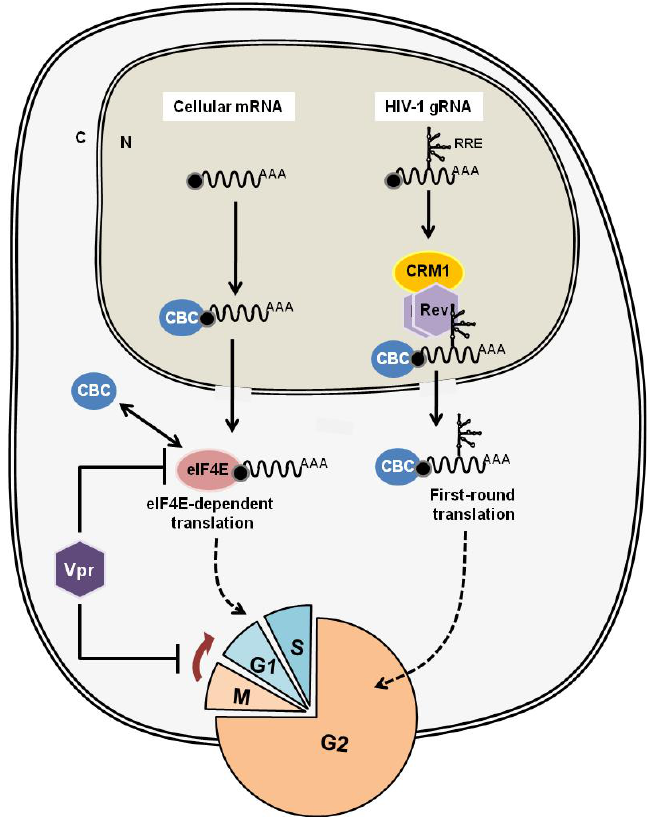
Figure 3. The G2-­‐‑arrest by Vpr is beneficial for the selective translation of viral proteins. In the regular mRNA translation, the m 7 G-­‐‑Cap structure of transcribed mRNA is first recognized by the Cap binding complex (CBC) and subjected to the pioneer round of translation for the quality check of mRNA. Then, CBC is replaced by the eIF4F complex for the steady-­‐‑state translational procedure, which is regulated by eIF4E within the eIF4F complex. The majority of eIF4E-­‐‑dependent translation is inhibited during G2 phase. On the other hand, CBC-­‐‑dependent pioneer-­‐‑round translation is cell-­‐‑cycle independent. Since the translation of a viral protein from HIV-­‐‑1 mRNA relies on CBC-­‐‑dependent pioneer-­‐‑round translation, G2-­‐‑arrest by Vpr can enhance the translation of viral proteins by suppressing the eIF4E-­‐‑dependent translation. Additionally, Vpr reduces the activated (phosphorylated) eIF4E level. Taken together, Vpr assists selective translation of HIV-­‐‑1 mRNAs by induction of G2-­‐‑arrest, as well as by suppression of eIF4E activity.